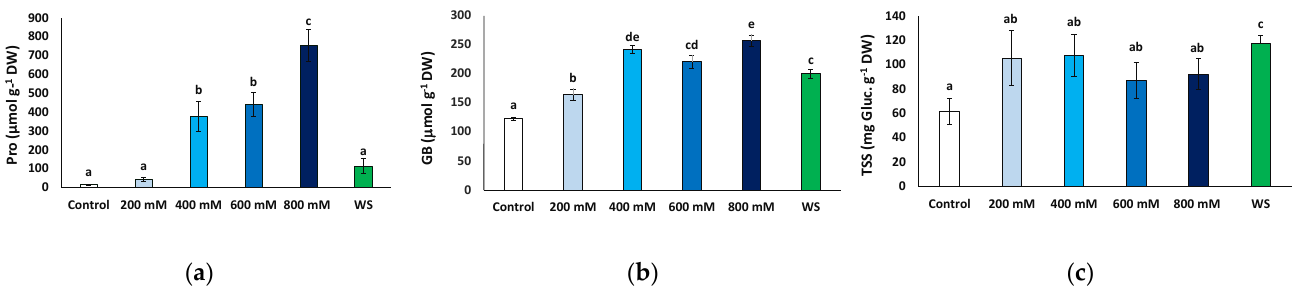
Figure 7. Osmolyte contents in leaves of Limonium angustebracteatum plants after one month of treatment with the indicated NaCl concentrations or one month of water stress (WS). ( a ) proline (Pro), ( b ) glycine betaine (GB), ( c ) total soluble sugars (TSS). Means ± SE, n = 6. Different lowercase letters above the bars indicate significant differences between treatments, according to Tukey’s test (α = 0.05).